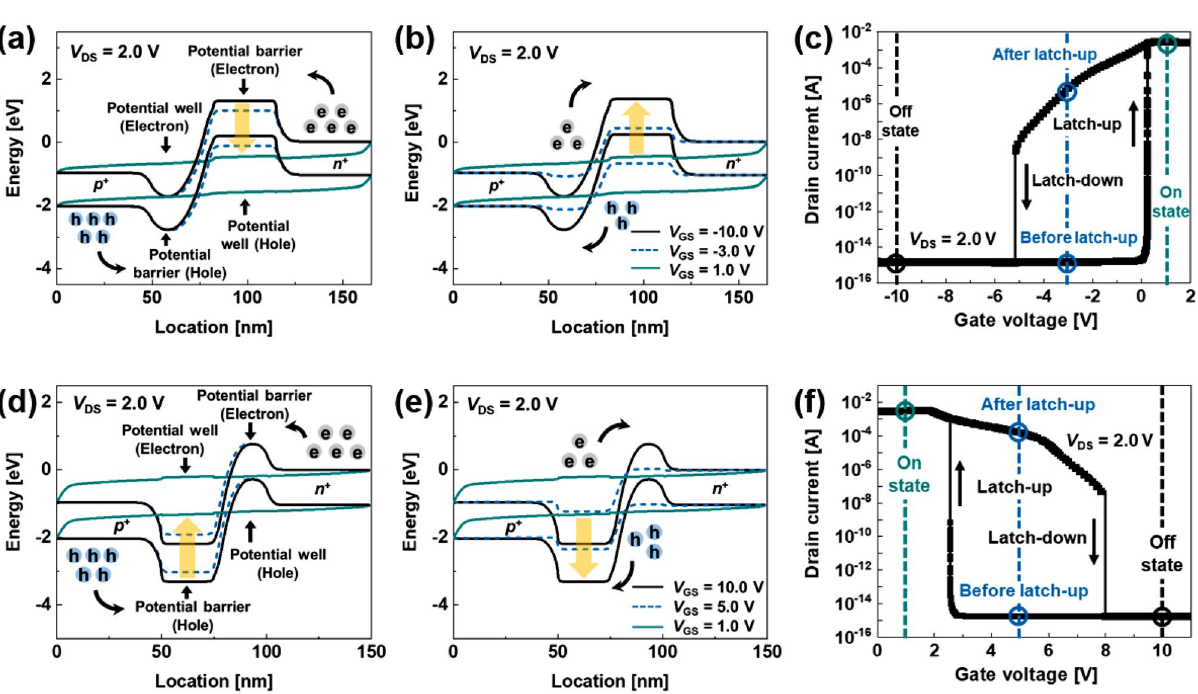
Figure 2. Energy band diagrams of n -FBFET ( a ) during positive sweeping and ( b ) negative sweeping of V GS . ( c ) I DS − V GS transfer curve of n -FBFET at a V DS of 2.0 V. Energy band diagrams of p -FBFET ( d ) during negative sweeping and ( e ) positive sweeping of V GS . ( f ) I DS − V GS transfer curve of p -FBFET at a V DS of 2.0